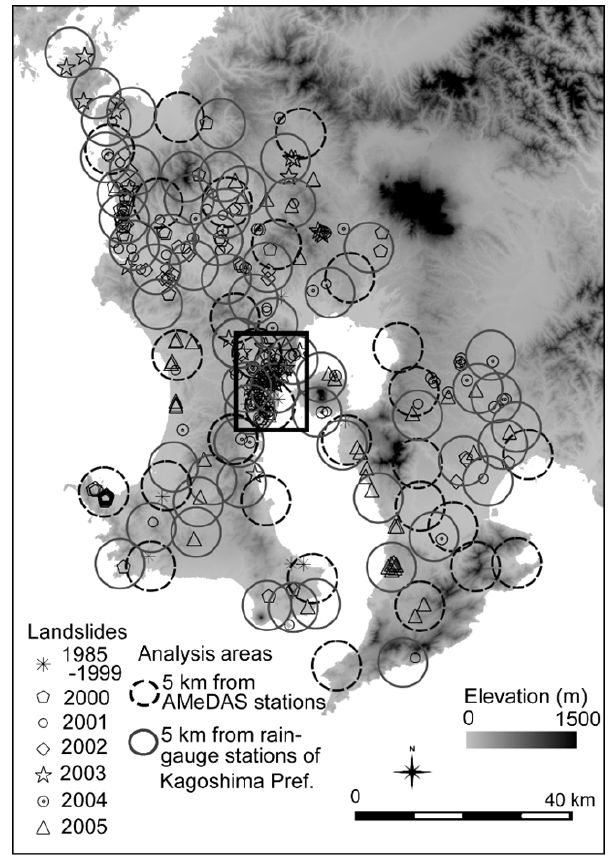
Figure 4. Locations of the Shirasu landslides in our database from 1985 to 2005 together with rain gauge stations in Kagoshima. Rect- angle shows the concentration of more than one-third of these dam- aging landslides in the city of Kagoshima.